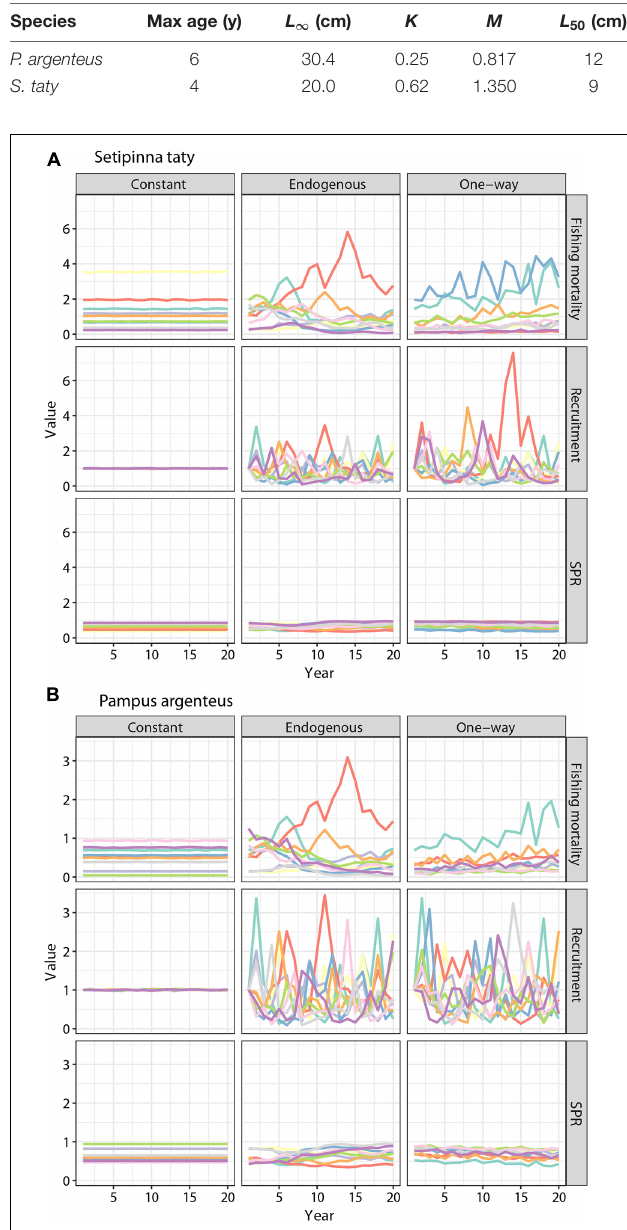
FIGURE 3 | Scenarios of fishing mortality and recruitment under equilibrium and variable conditions for the three life-history types. The lines show 10 randomly chosen iterations out of 100 as examples. (A) S. taty. (B) P.